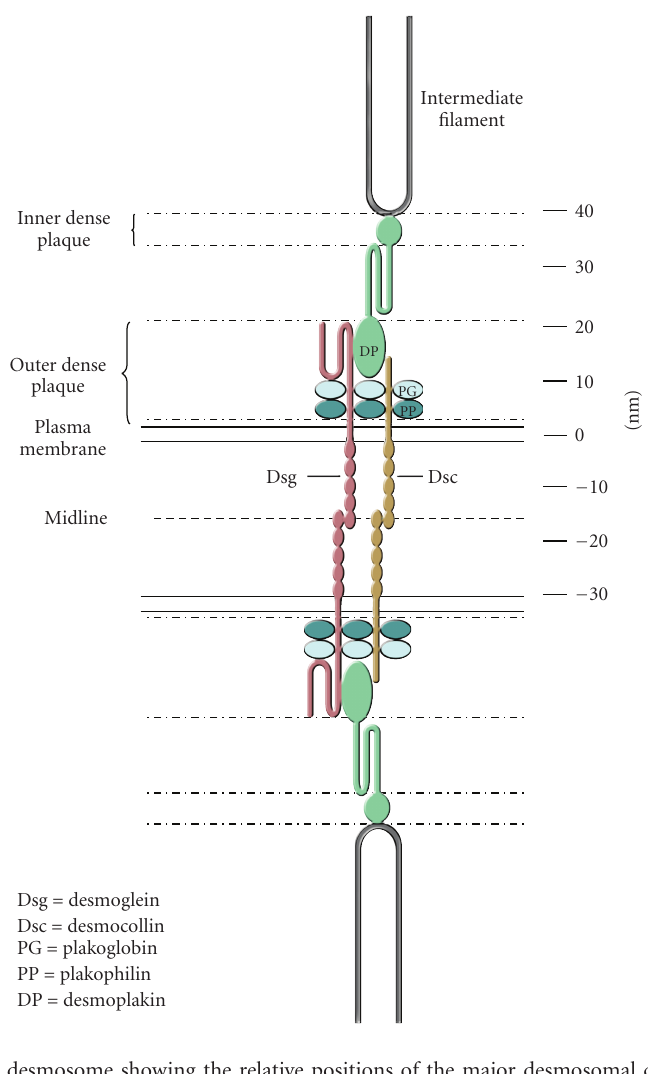
Figure 1: Schematic model of a desmosome showing the relative positions of the major desmosomal components. (See Figure 4 for an electron micrograph of desmosomes.) The scale on the right-hand side indicates distance in nanometres. The figure is largely based on the immunogold labelling experiments of North et al. [8]. Reproduced from the study by Garrod and Chidgey in